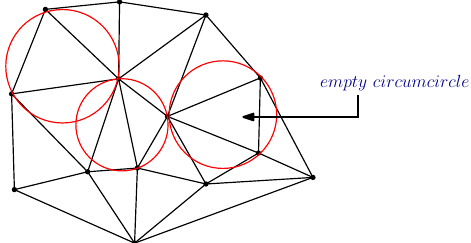
Figure 3: Delaunay Triangulation of a set of points